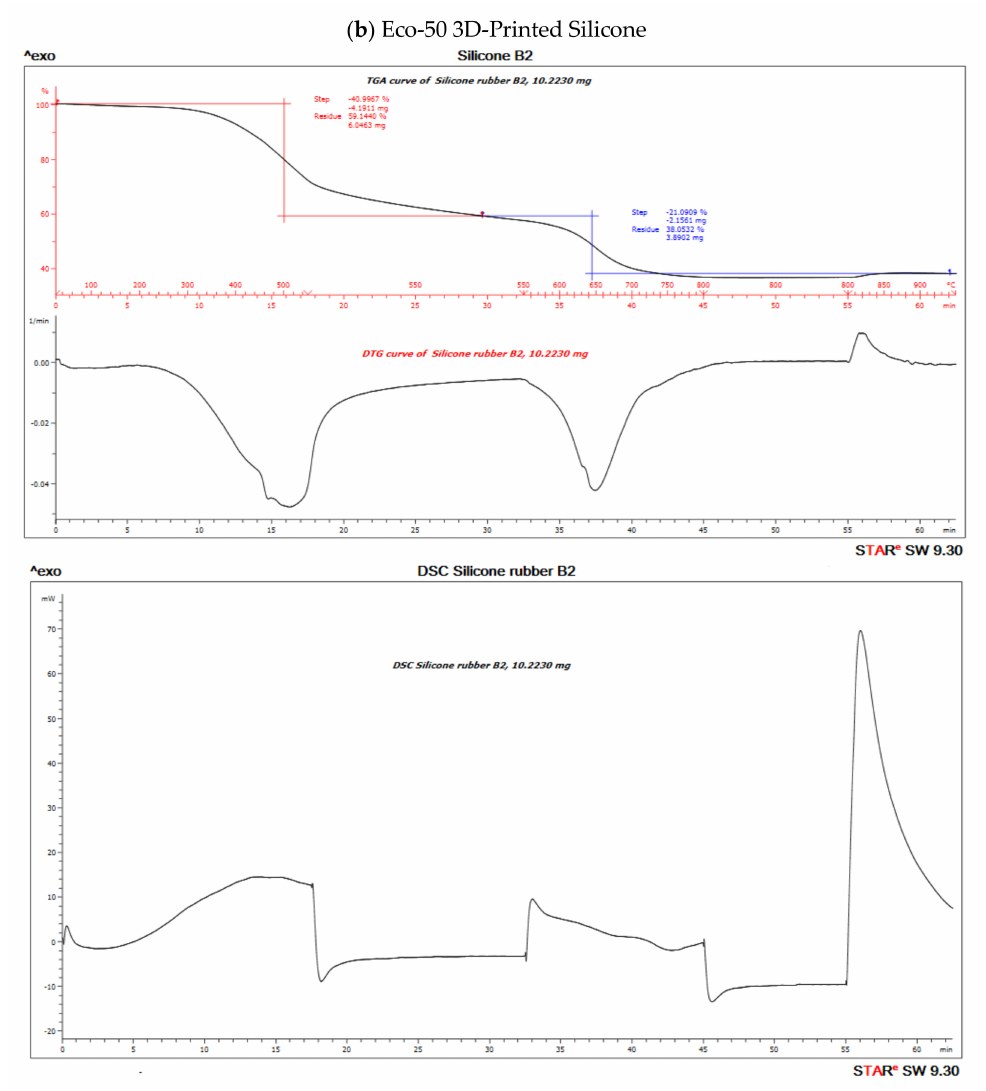
Figure 10. Thermo-gravimetric analysis / di ff erential scanning calorimentry (TGA / DSC) curves of ( a ) molded and ( b ) 3D-Printed silicone Ecoflex 50 measured from 30 to 700 ◦ C at a heat rate of 20 K / min. The TGA curve (red) measures the loss of mass and the DSC curve (black) provides information about endothermic and exothermic e ff